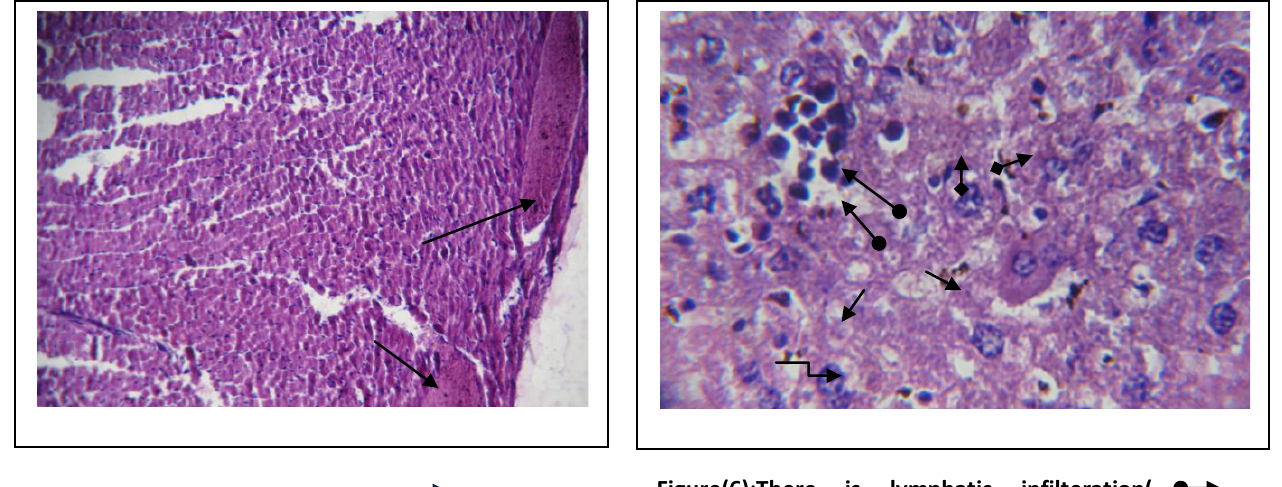
Figure(5):There is only thrombosis( ) in the heart. (H&E